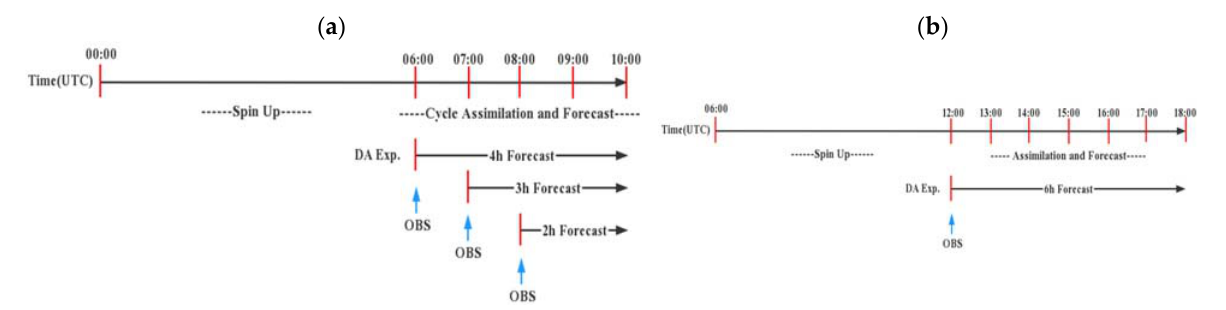
Figure 3. Flowcharts of spin-up, data assimilation, and forecast for the ( a ) convective case and ( b ) continuous monthly experiments.